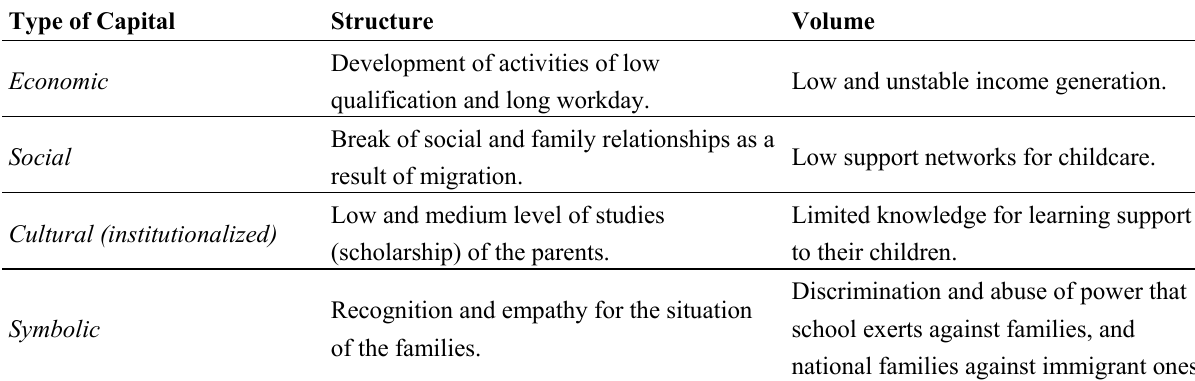
Table 3. Difficulties in terms of family